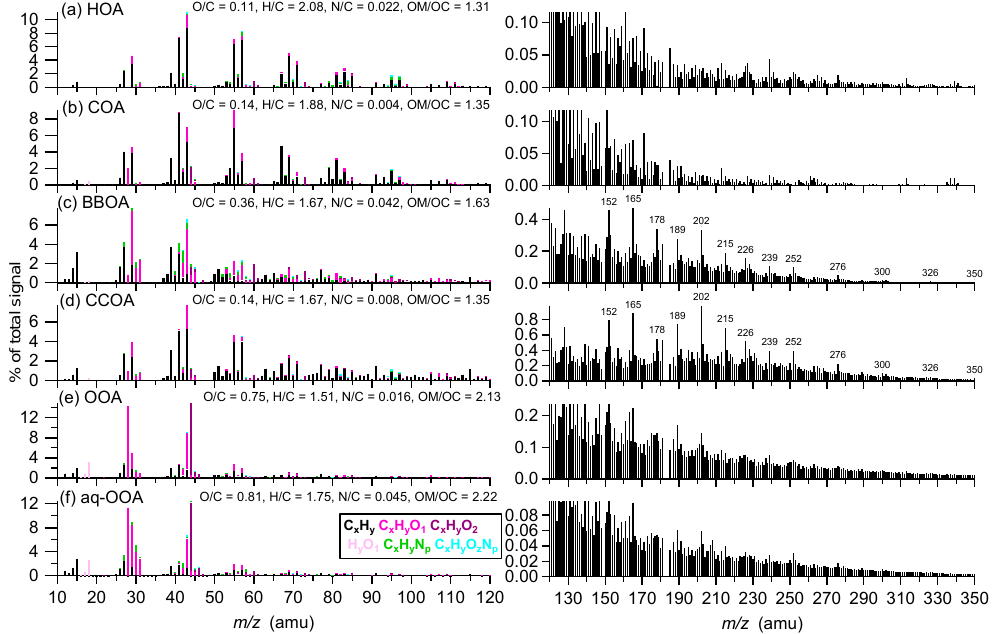
Figure 7. Left panel: high resolution mass spectra of six OA factors. Right panel: unit mass resolution spectra ( m/z 120–350) of six OA factors.